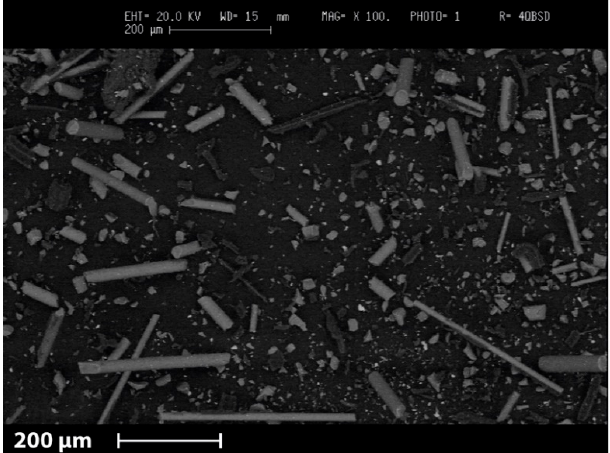
Figure 2. SEM micrograph of GAM fine glass fiber recyclate showing the presence of fibers with different length and/or diameter.